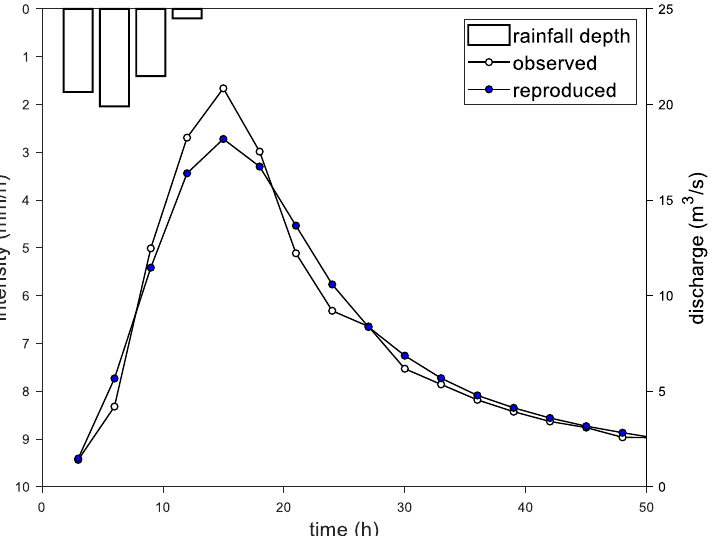
Figure 6. Comparison of observed hydrograph and hydrograph reproduced by the proposed pro- cedure for selected storm (in Nenagh